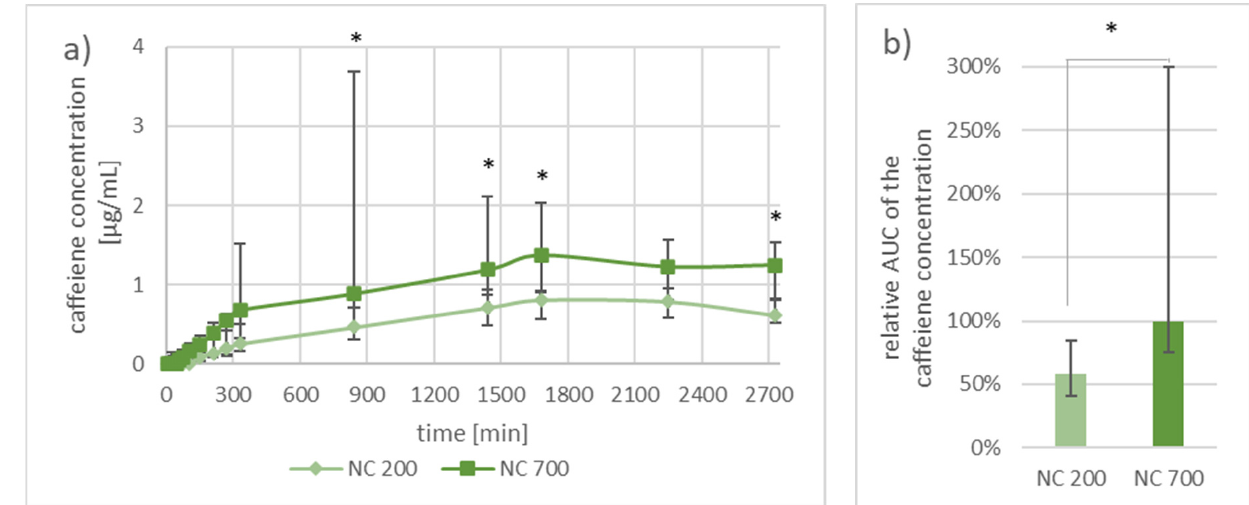
Figure 6. Graph ( a ) presents the median ± one quartile caffeine concentration sampled by microdialysis from the two investigated areas on porcine ear skin with 200 nm nanocrystals (200 NC) and 700 nm (700 NC) at different time points. Graph ( b ) shows the median ± one quartile area under the curve from the obtained caffeine concentration data. Two nanocrystal gel formulations were compared to each other in both graphics. Differences between two areas of p < 0.05 were considered as significant (*). n = 5.